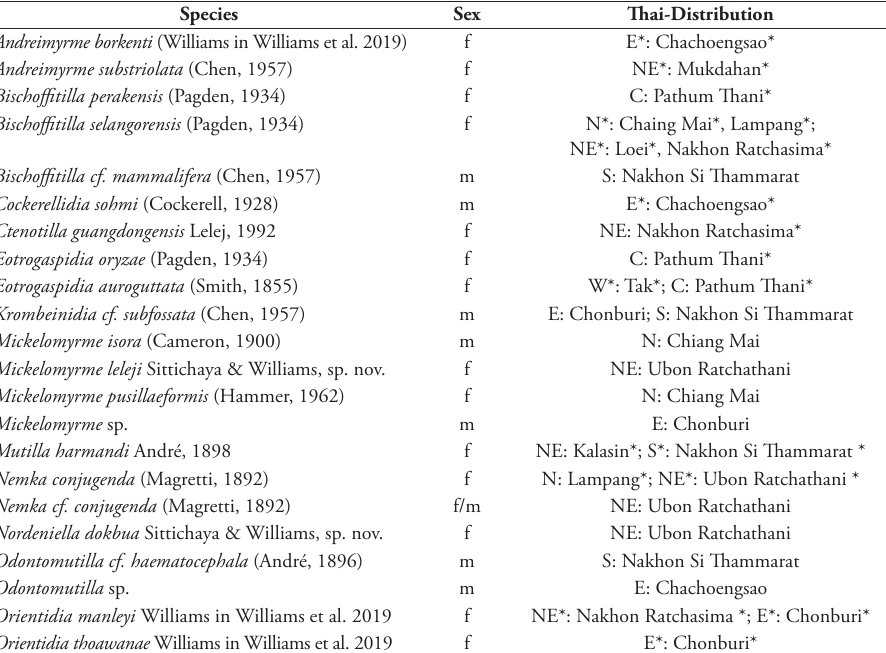
Table 1. Synoptic list of velvet ants in the Thailand Natural History Museum. Asterisks (*) represent new distribution records for the Region or